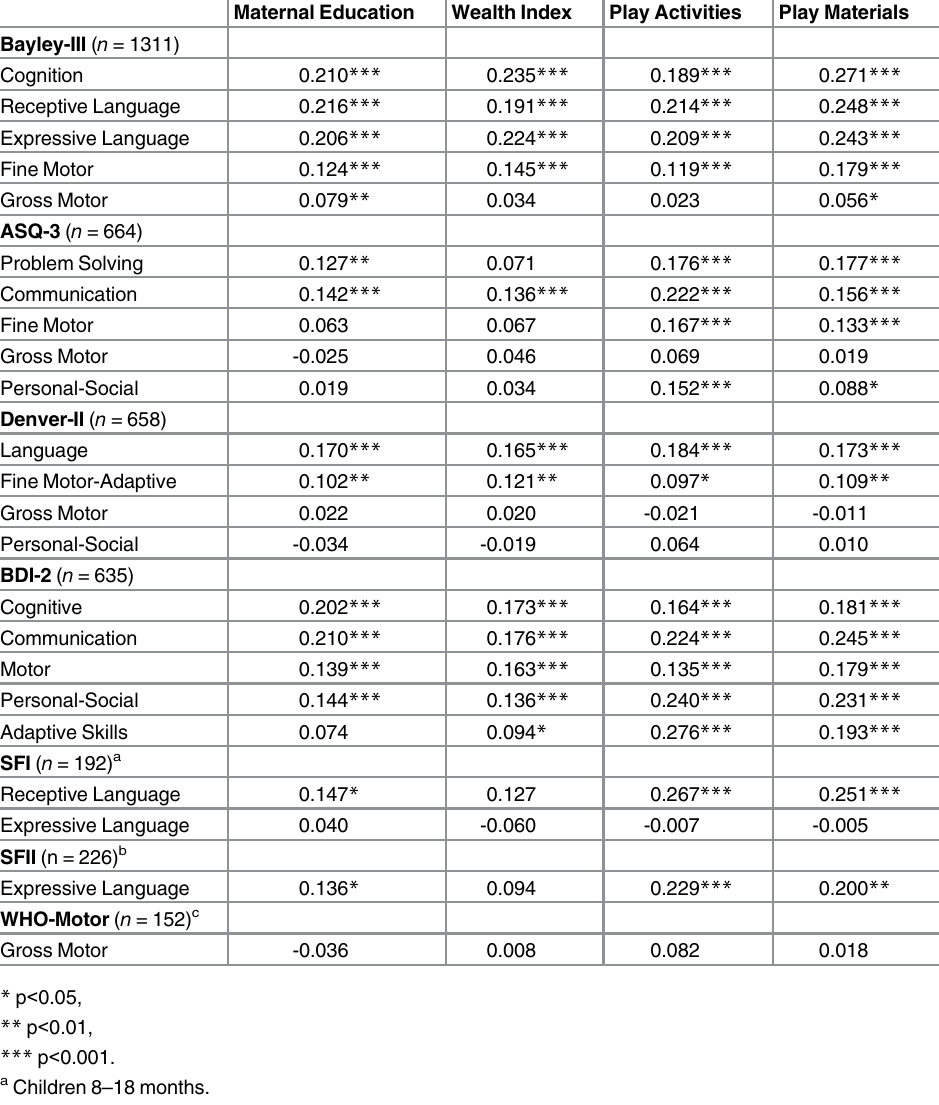
Table 4. Correlations of the Bayley-III and the Short Tests with Maternal Education, Household Wealth, Play Activities and Play Materials in the Home, All Ages